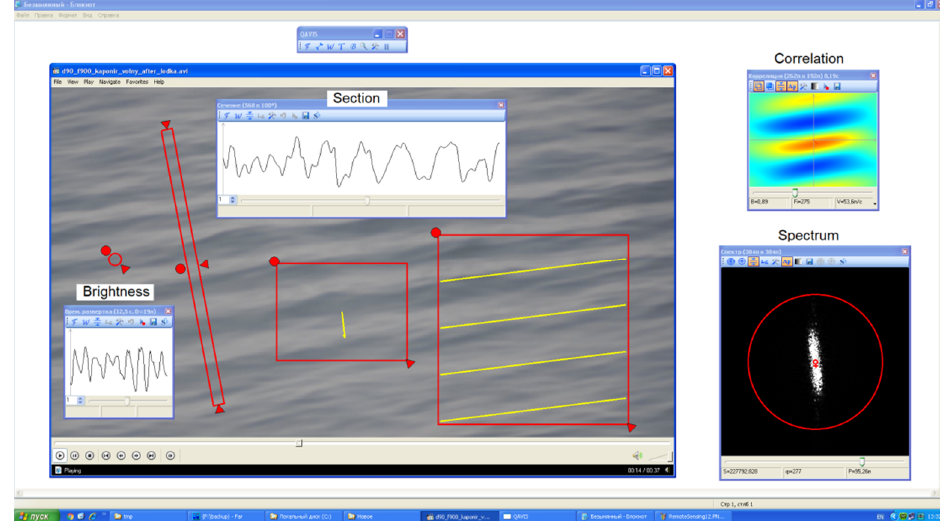
Figure 4. Basic QAVIS tools. The red selectors of the Brightness, Transect, Correlation, and Spectrum tools are arranged in order from left to right. The current results of the tools are displayed in the corresponding information windows.